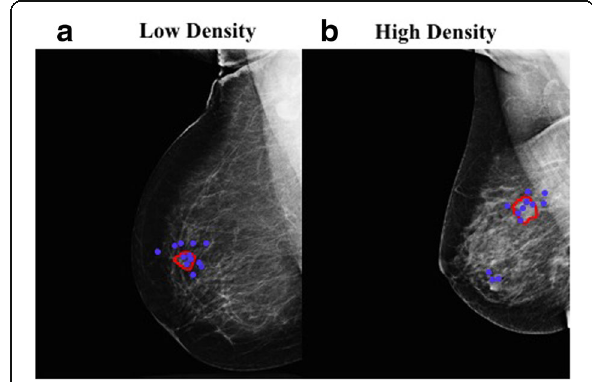
Fig. 5 Exemplars from the target present stimuli set illustrating the mass ( red outline , not shown in the experiment) and localisation responses of the 12 radiologists ( blue ) collapsed across duration. a Low-density image showing precision errors. The blue mouse-clicks for localisation show that the eight radiologists who were ‘ incorrect ’ on this image may have information about the location of the target. b High-density image showing the effect of a naturally occurring distractor. Three radiologists localised the distractor as the abnormality (note a further four ‘ incorrect ’ responses are near the mass ( red outline ) but